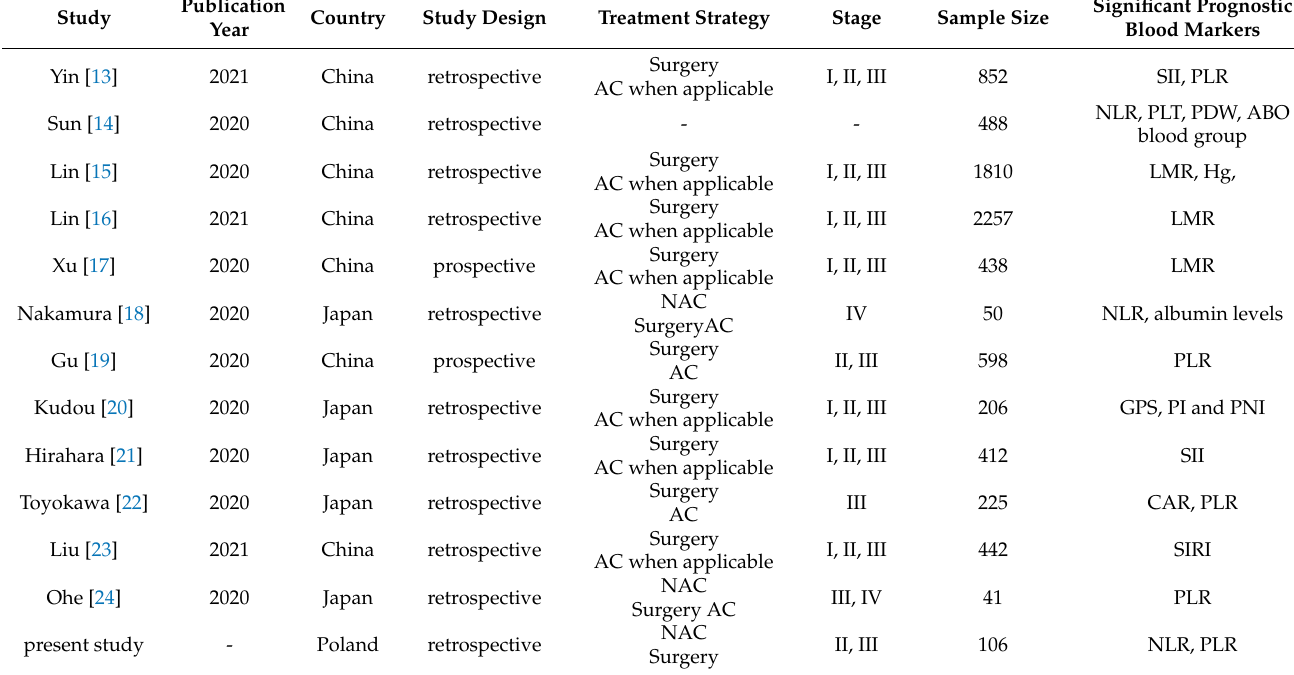
Table 4. Baseline characteristics of the selected studies in comparison to the results of the present